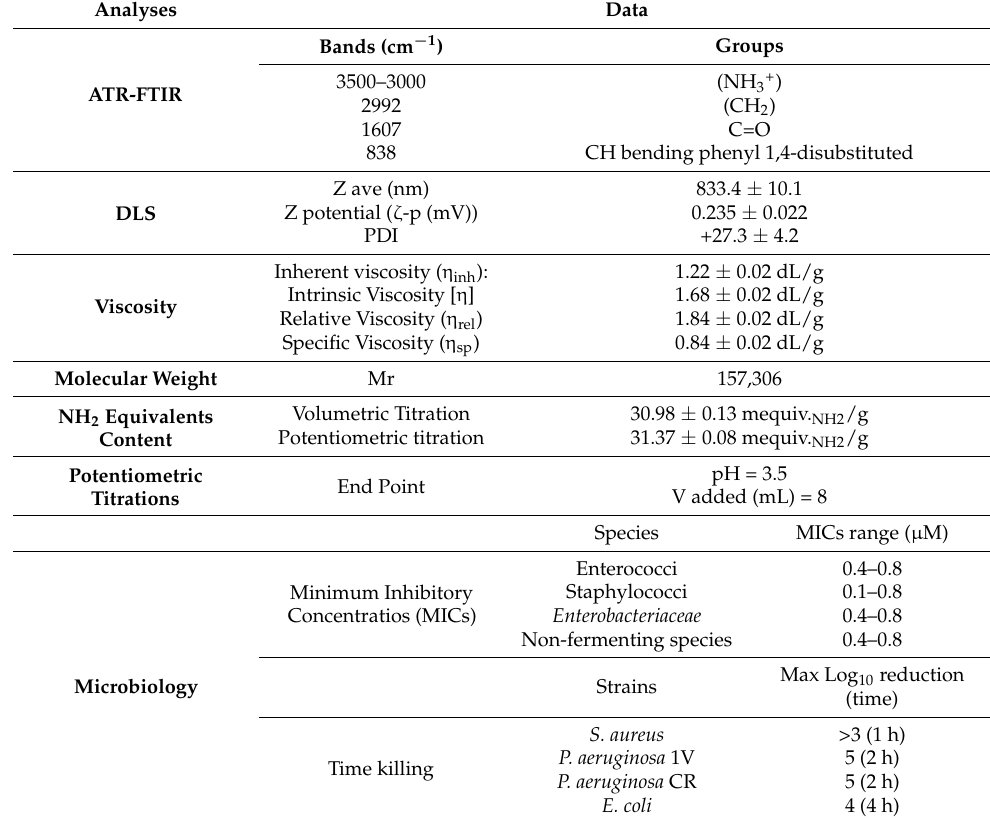
Table 1. Characterization data of CP1 here used as single ingredient to prepare